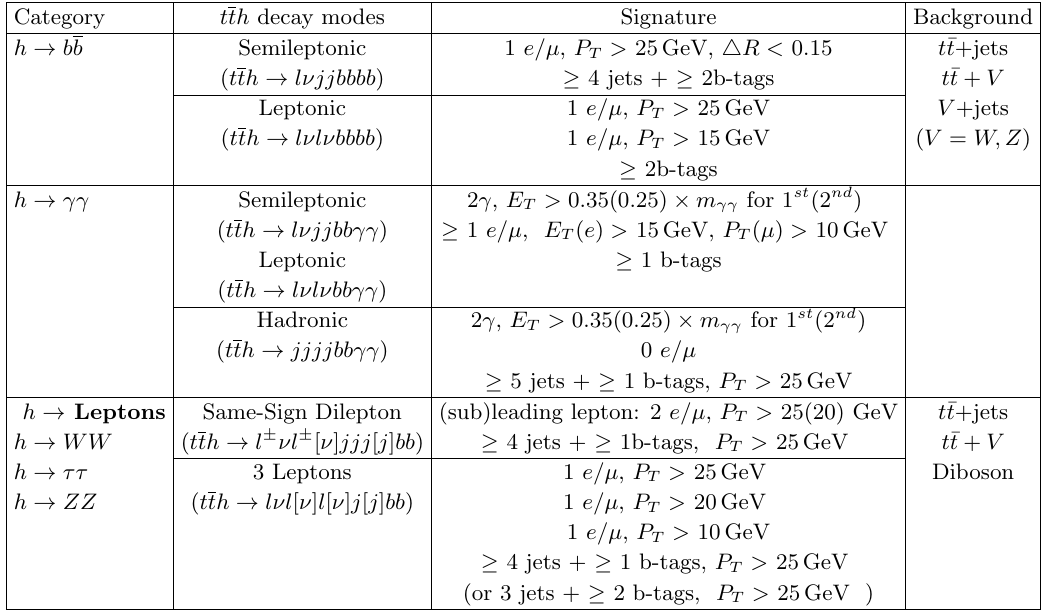
Table 3 . The signature of the search channels used in the tth analysis for